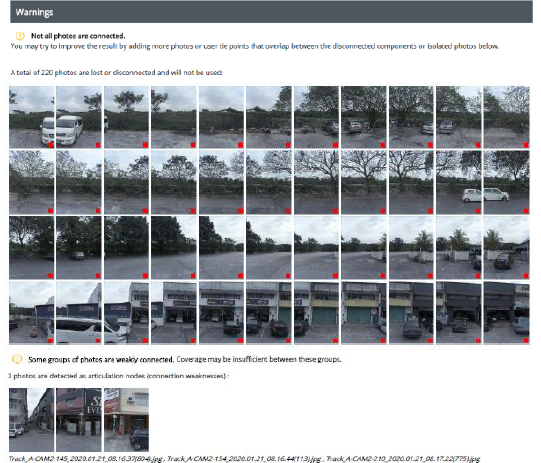
Figure 3: Warning issues by the software in acquisition